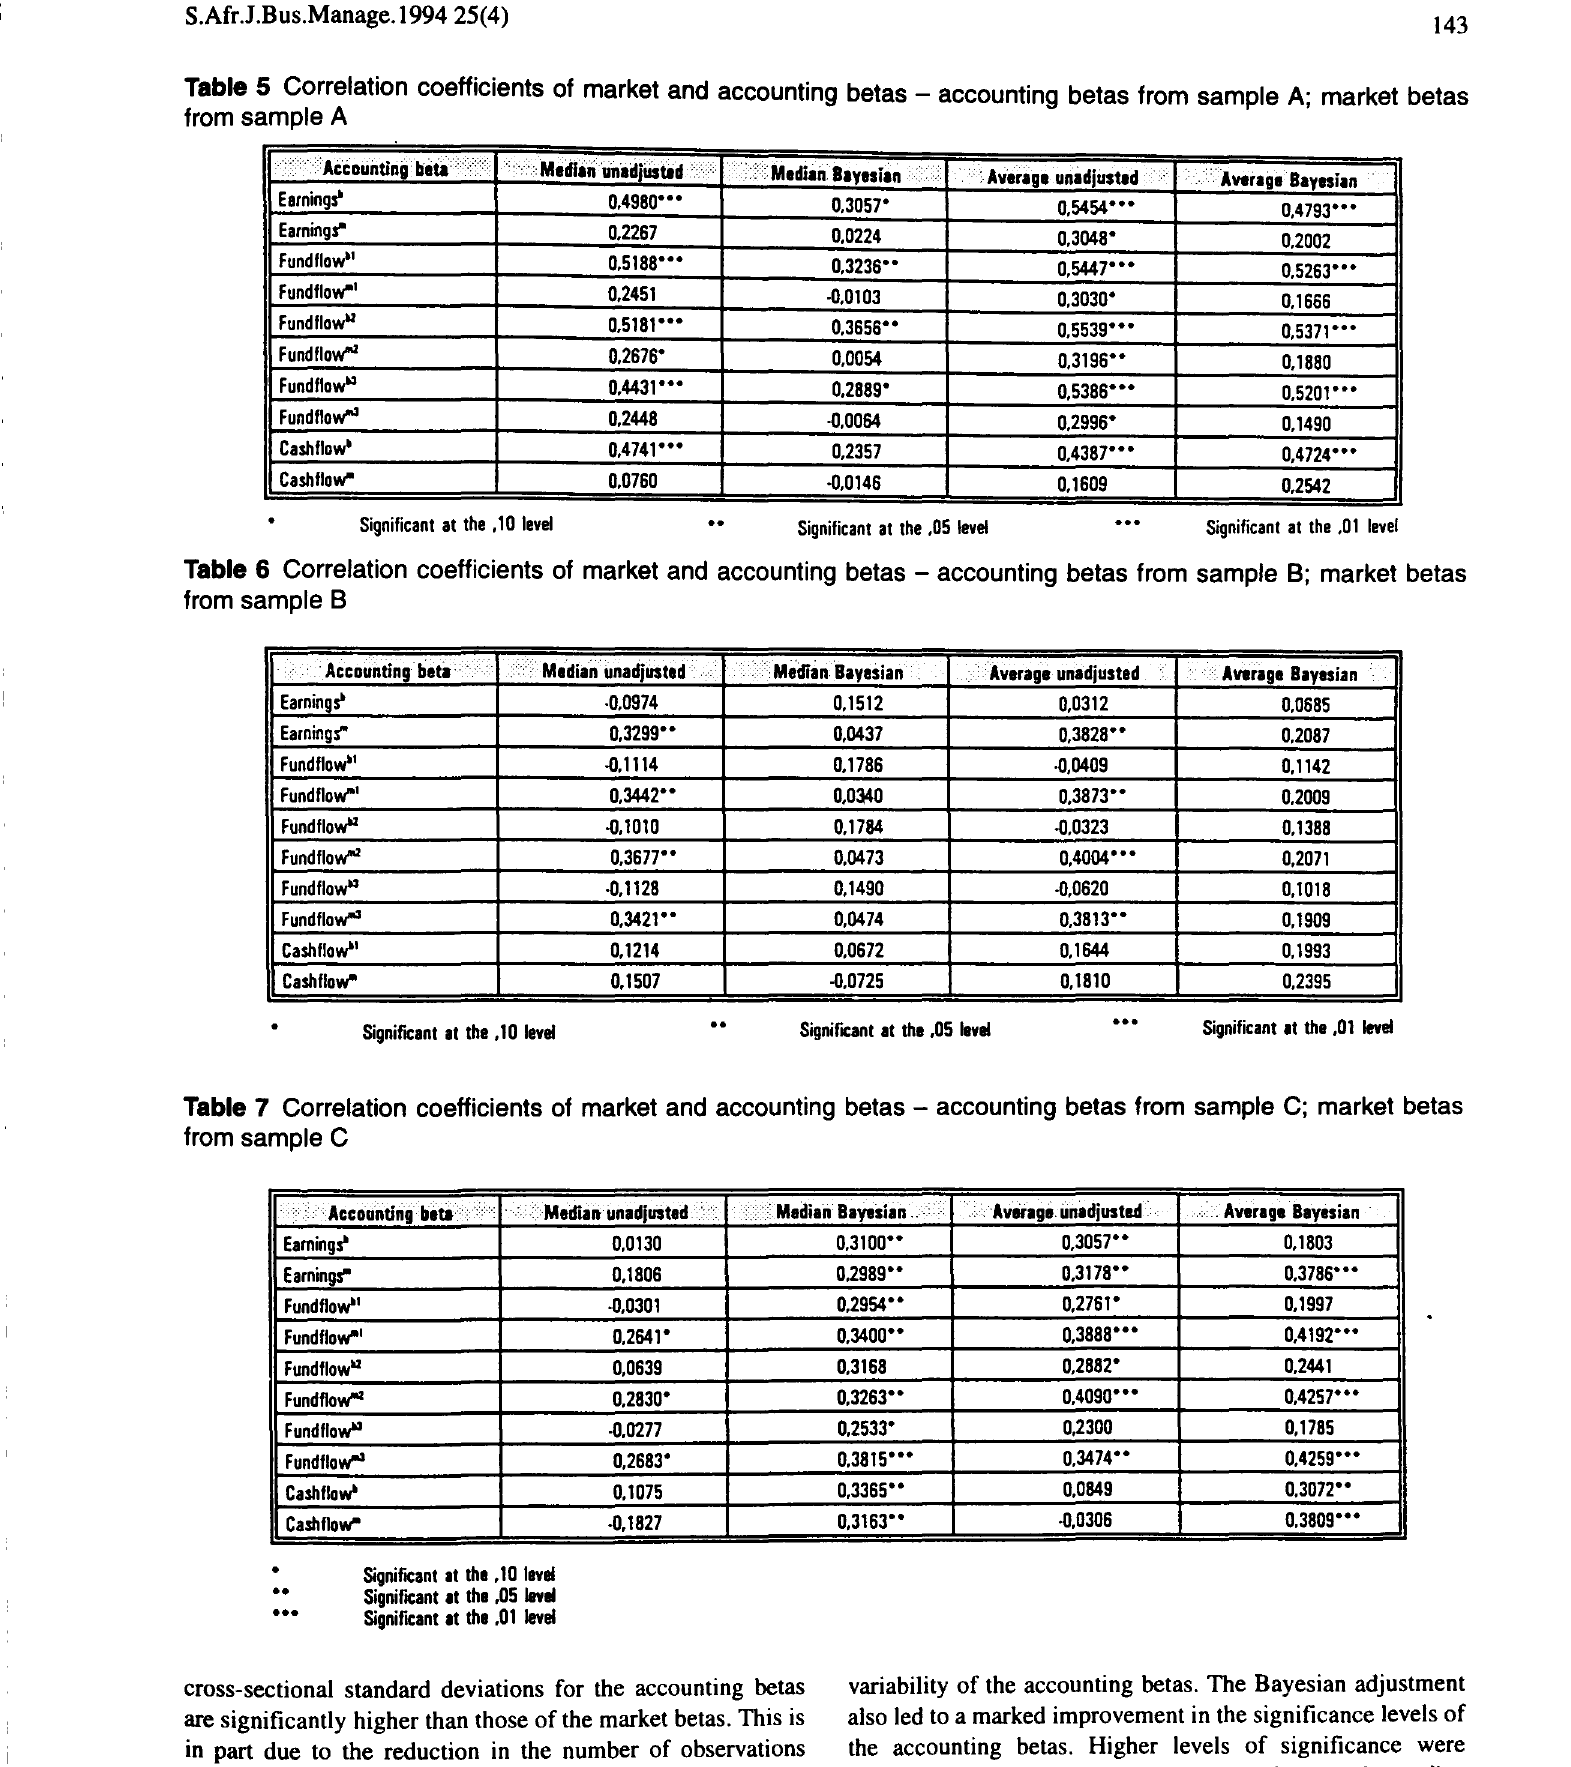
Table 5 Correlation coefficients of market and accounting betas - accounting betas from sample A· market betas from sample A